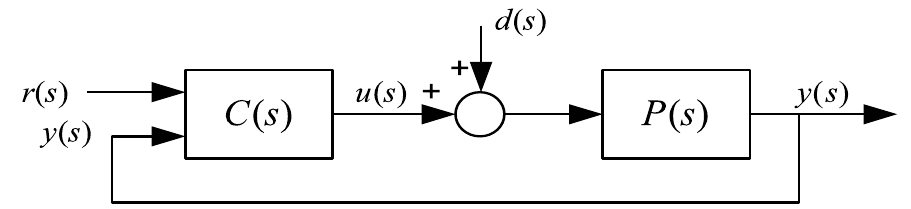
Figure 1. Closed-loop control